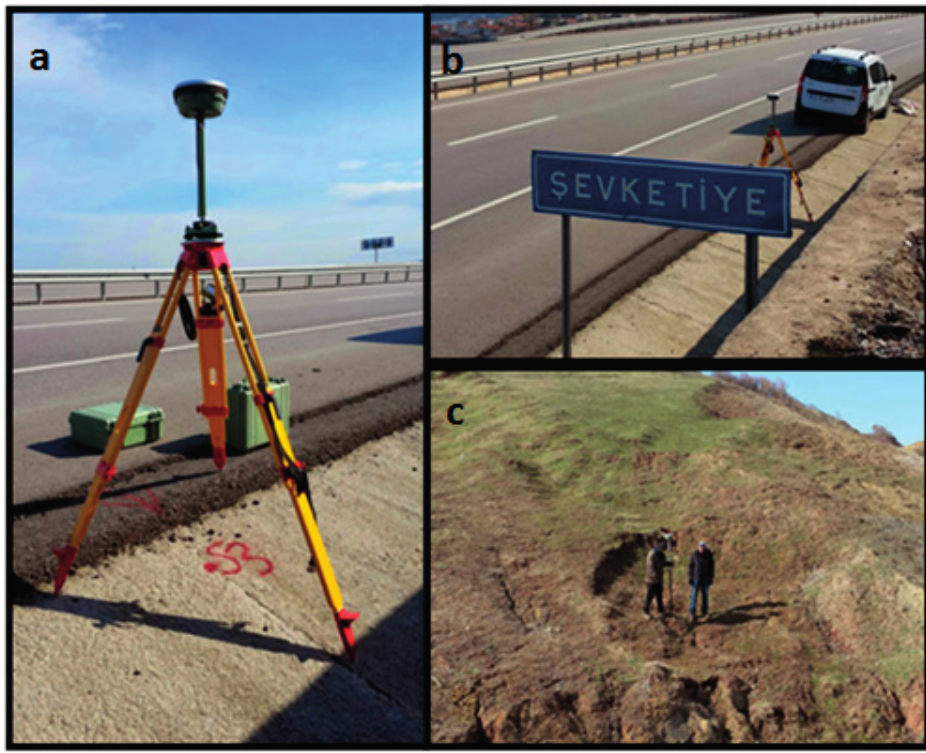
Figure 4. ( a ) The base station Global Navigation Satellite System (GNSS) receiver; ( b ) The base station GNSS receiver from different view angle; ( c ) mobile GNSS receiver on the landslide